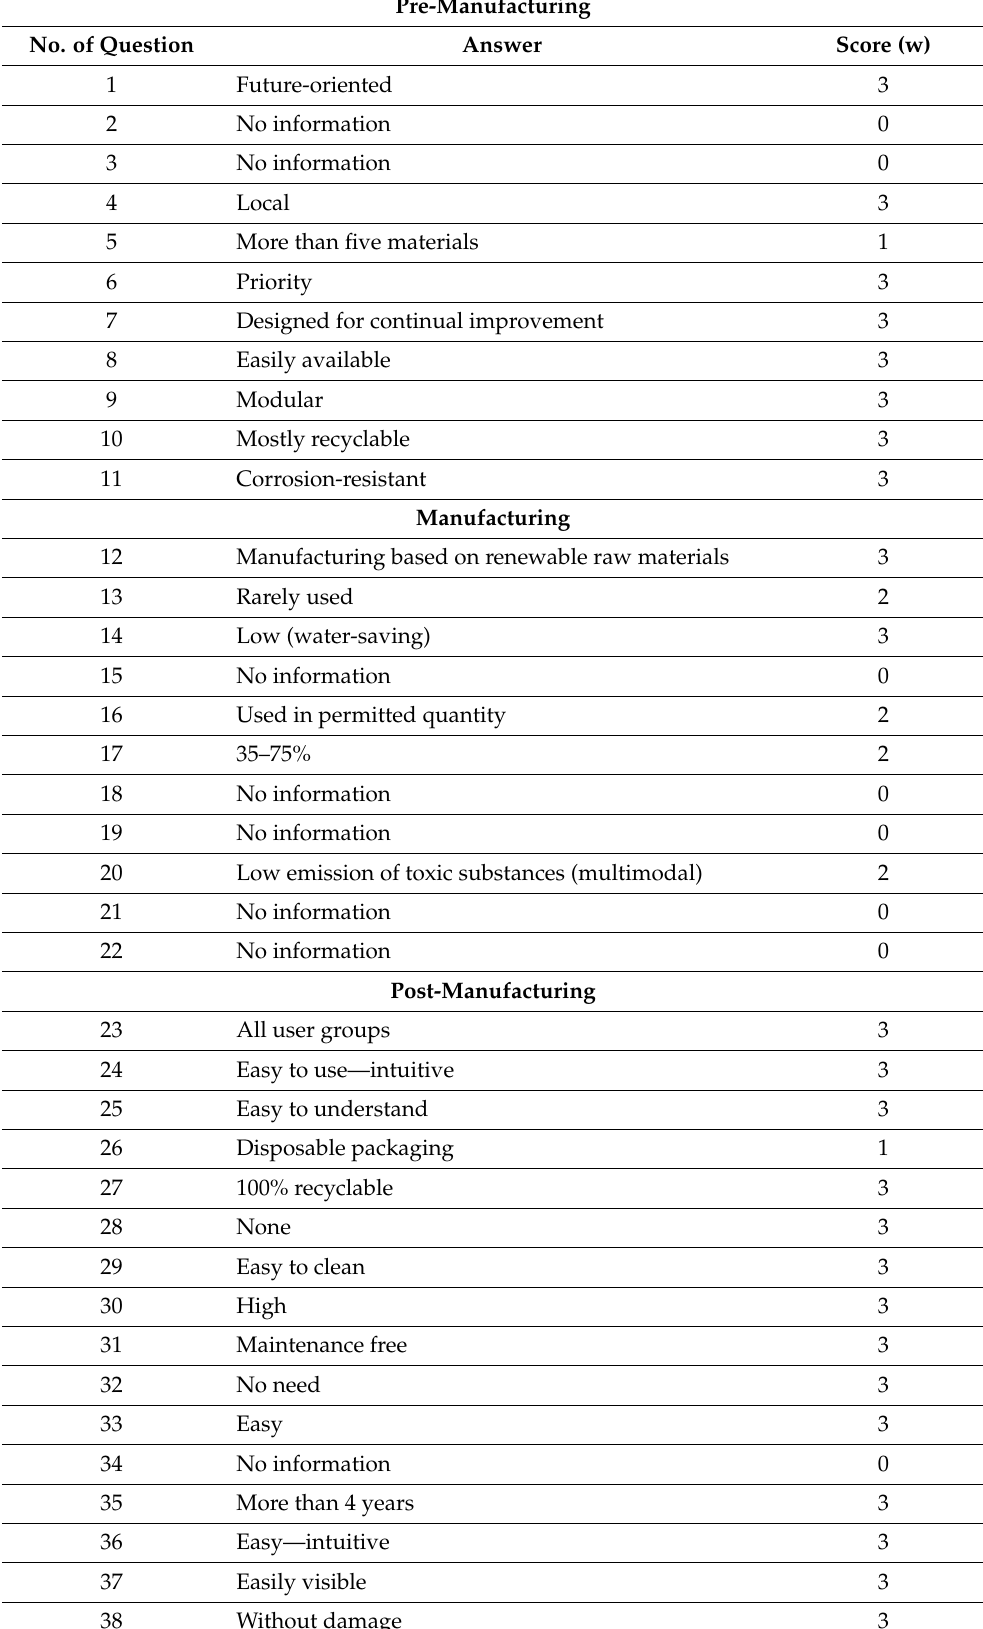
Table 6. Environmental quality